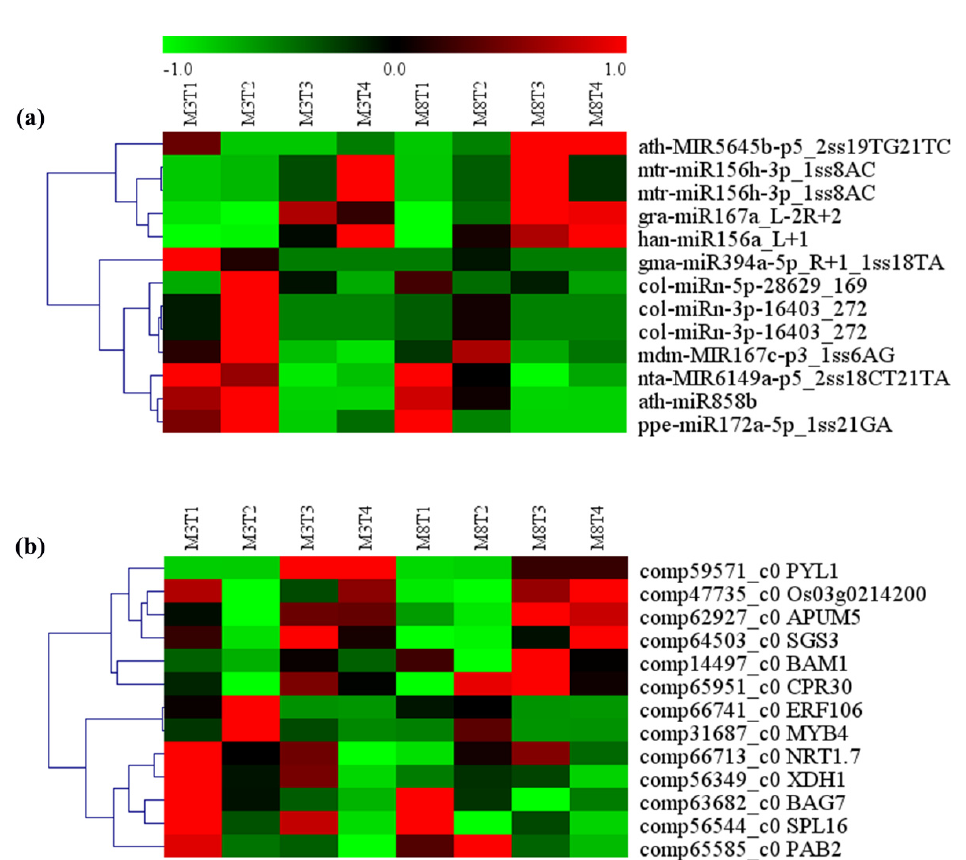
Figure 11. Heat map analysis of ( a ) predicted differentially expressed miRNAs, and ( b ) their target genes, related to resistance, yield, and quality from the seeds of the ‘M3’ and ‘M8’ cultivars at four developmental stages. Red and green colors indicate high levels and low levels, respectively, of the miRNAs and their targets.